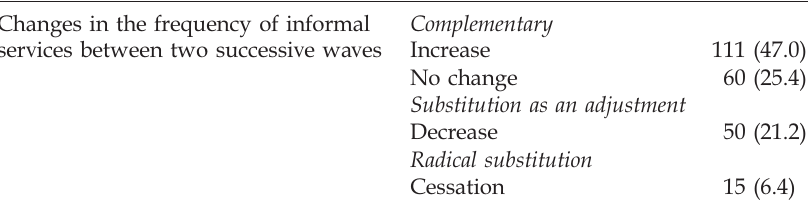
Table 5. Changes in the frequency of informal ser v ices between two successi v e wa v es when the frequency of formal ser v ices increases, number of inter v iews